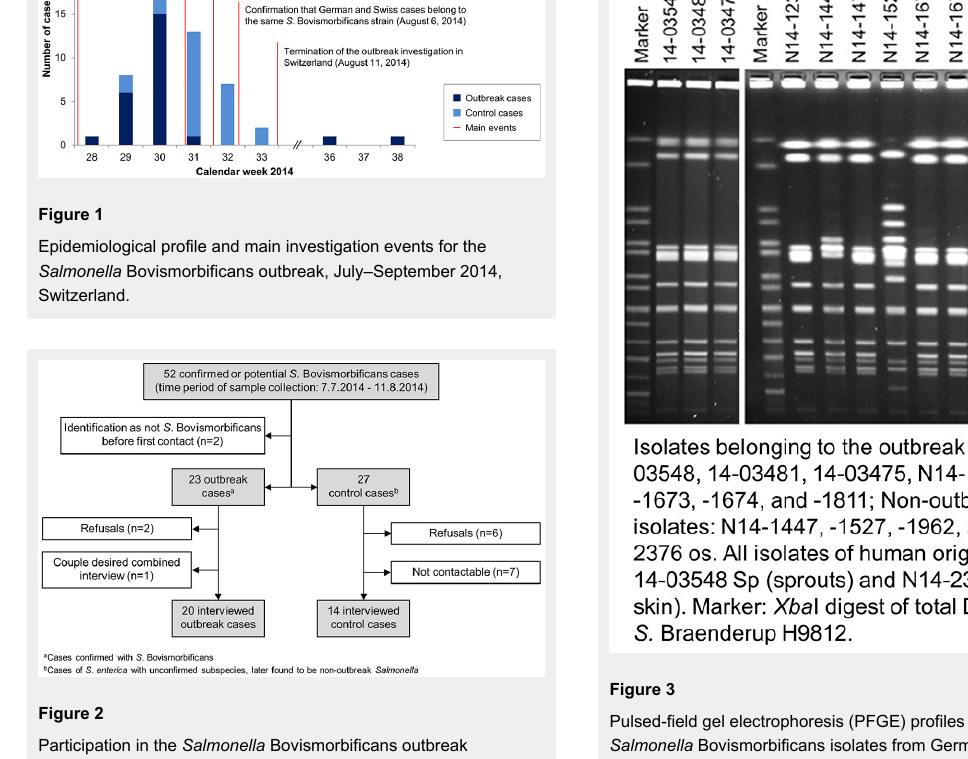
Participation in the Salmonella Bovismorbificans outbreak investigation, July–August 2014, Switzerland.